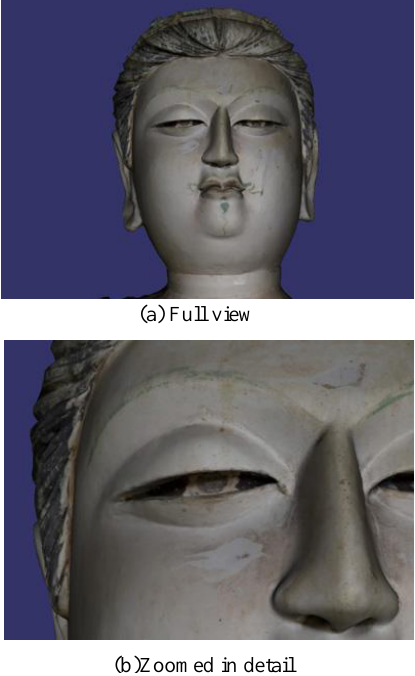
Figure 2. Result of non-rigid texture mapping of experiment 1. Experiment 2 In some other cases, the surface of geometric model is too smooth to select 2D-3D control point accurate enough, whereas the intensity of point cloud can be used to facilitate the selection of controls points on 3D model. The color sculpture of Experiment 2 is a sitting Buddha in Cave 285, the texture image, geometric model and selected corresponding control points are displayed in Figure 3 as below. Because this sculpture is closely backed by wall on which some control points are selected for the sake of increasing range level of control points, obtaining larger area on image and solving more accurate DLT